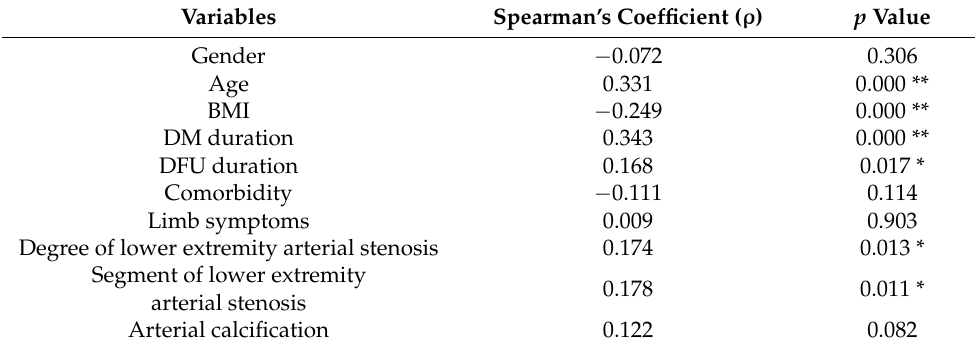
Table 3. Spearman’s rank correlation analysis between Wagner Score and predictors.